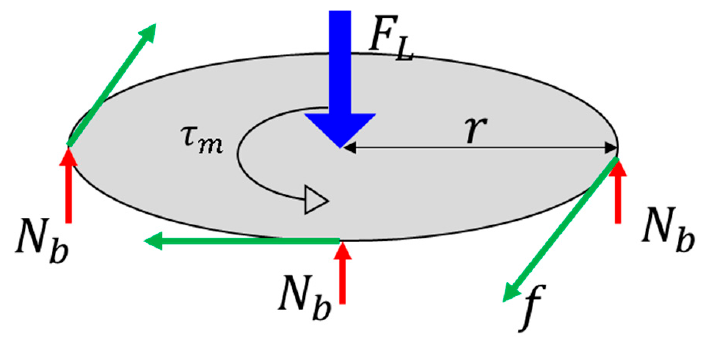
Figure 3. Central rotational free-body diagram.